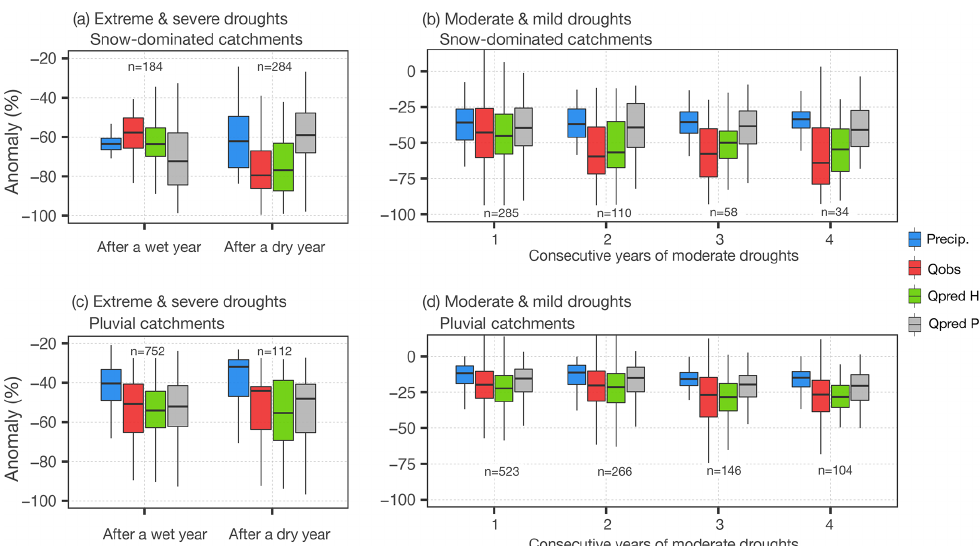
Figure 9. Observed and simulated annual drought propagation for consecutive dry years. Panel (a) presents the results for snow-dominated catchments and (b) for pluvial catchments. The number of cases is presented for each set of box